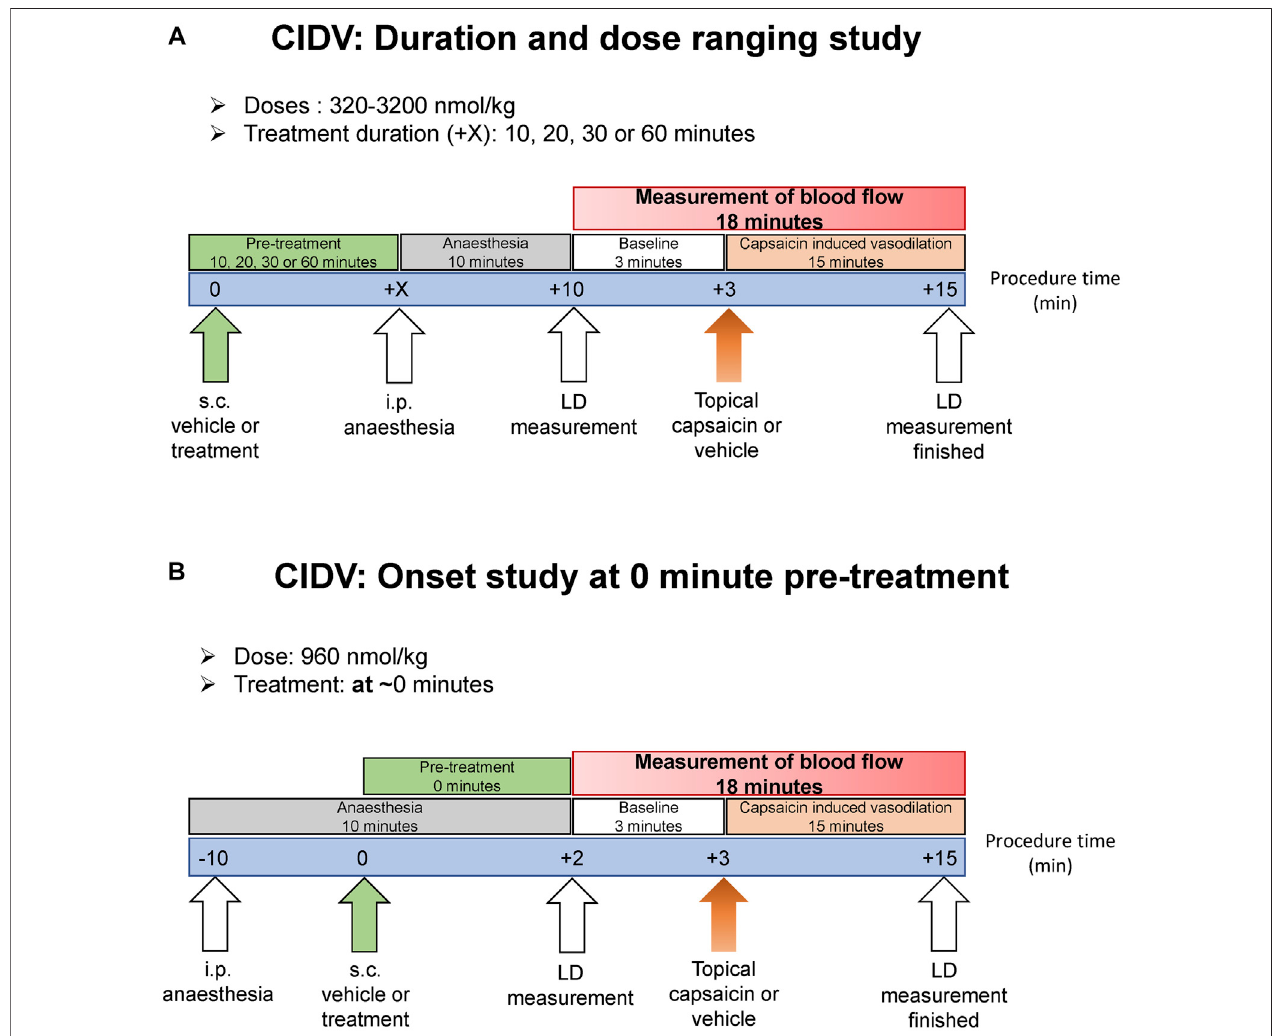
FIGURE1| Schematicshowingthelaserdopplerexperimentalprotocoltomeasure capsaicin-induceddermalvasodilation(CIDV) andantagonisteffectofpeptide and small molecule antagonists. (A) Antagonist screening, dose ranging and dose-duration studies. (B) Onset study at 0 min.